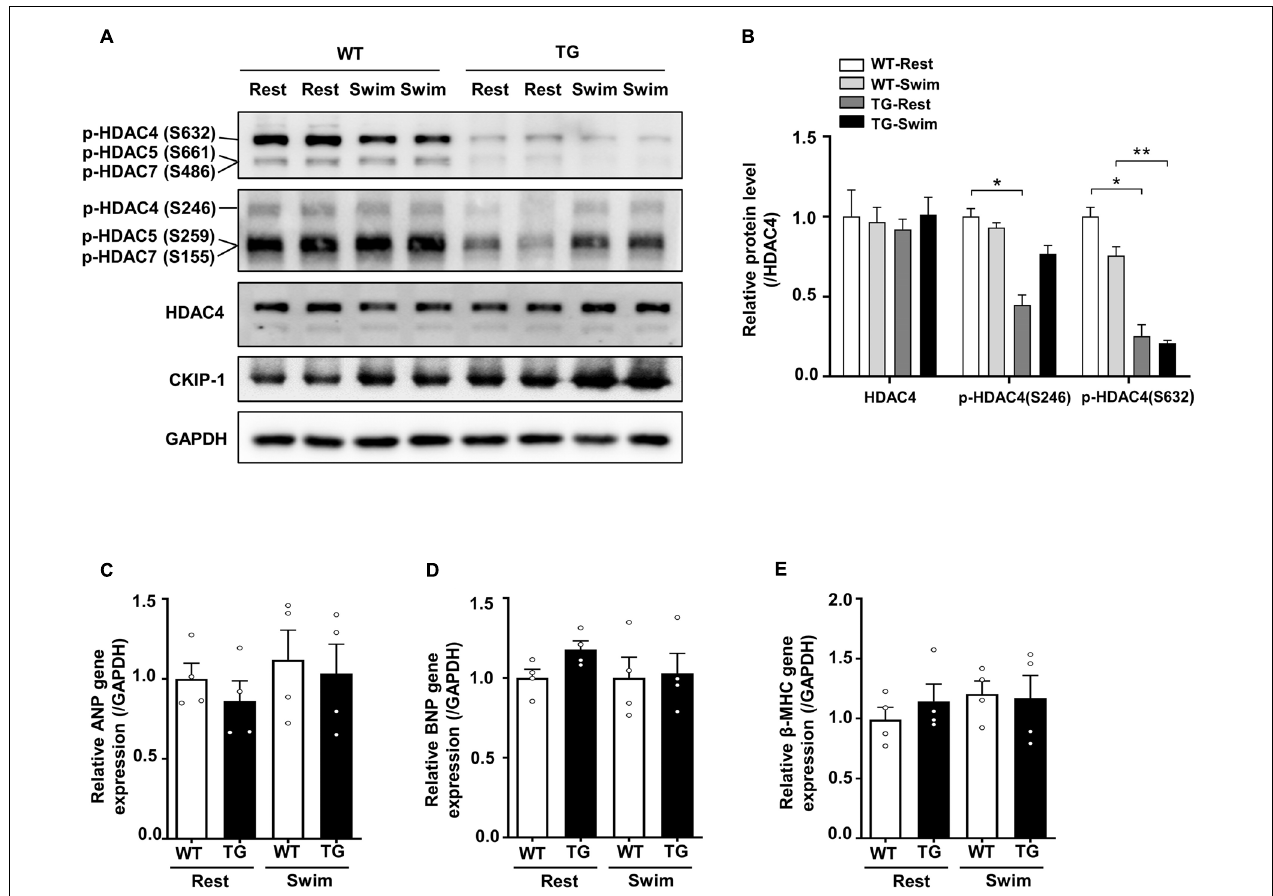
FIGURE 5 | Overexpression of CKIP-1 inhibits the phosphorylation of HDAC4. (A) Western blotting showing the expression levels of CKIP-1, phosphorylated HDAC4 (S632), phosphorylated HDAC4 (S246), and the total protein expression levels of HDAC4. (B) Quantification of p-HDAC4 (S632), p-HDAC4 (S246), and HDAC4 levels. (C–E) Transcript levels of hypertrophic marker genes (ANP, BNP, and β -MHC) in the hearts of WT and CKIP-1 TG mice after swimming exercise. Values are means ± SEM, n = 4 ∼ 6, ∗ P < 0.05, ∗∗ P < 0.01. Statistical differences among groups were analyzed by two-way analysis of variance (ANOVA) followed by the Bonferroni procedure. CKIP-1, casein kinase-2 interacting protein-1; WT, wild type; TG, transgenic; HDAC4, histone deacetylase 4; ANP, atrial natriuretic peptide; BNP, brain natriuretic peptide; β -MHC, myosin heavy chain β